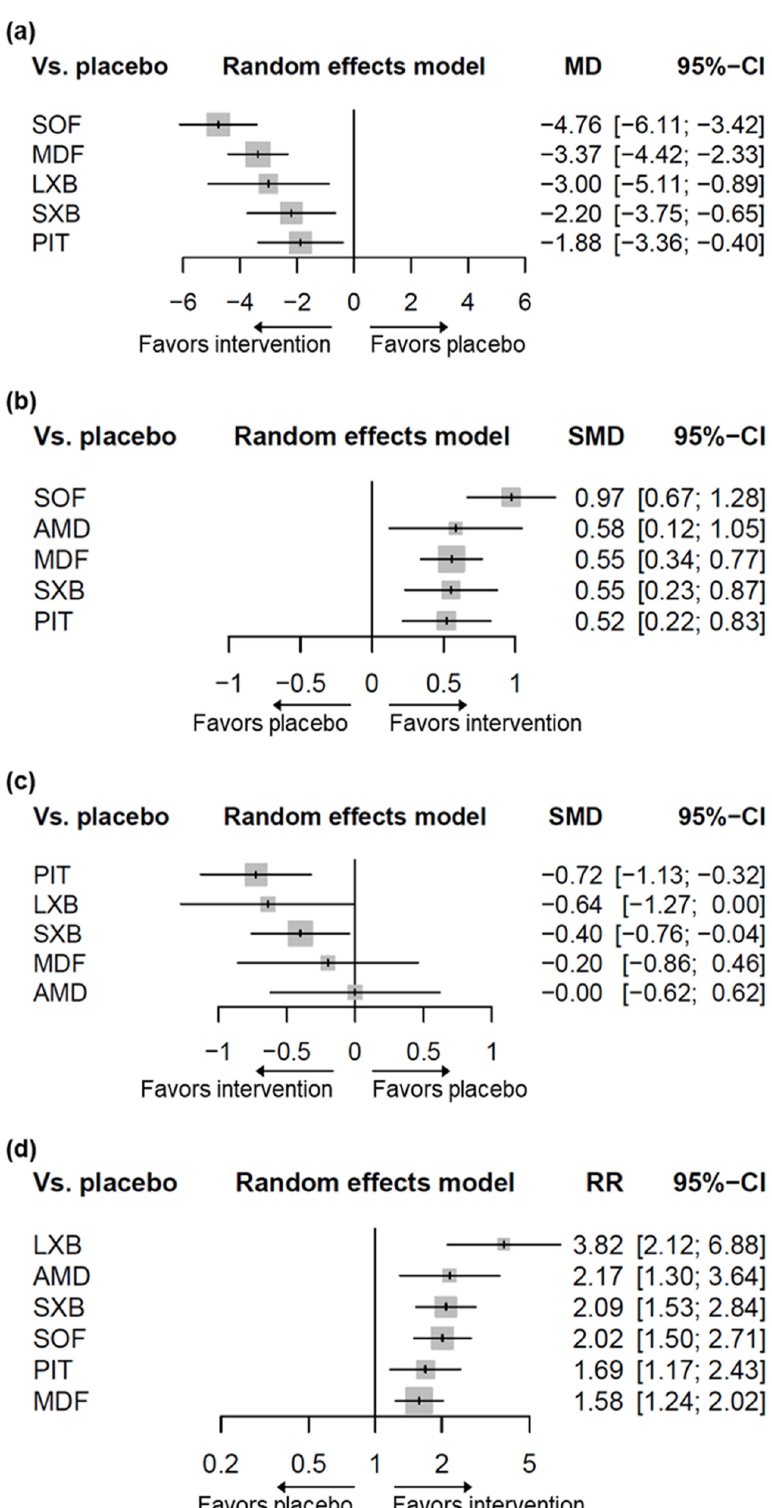
Figure 3. Forest plots for the outcomes of interventions compared to placebo. ( a ) Change in ESS. ( b ) Change in MWT. ( c ) Change in cataplexy rate. ( d ) CGI-C. ESS, Epworth Sleepiness Scale; MWT, Maintenance of Wakefulness Test; CGI-C, Clinical Global Impression of Change; SOF, solriamfetol; LXB, lower-sodium oxybate; MDF, modafinil; SXB, sodium oxybate; PIT, pitolisant; AMD, armodafinil; MD, mean difference; SMD, standardized mean difference; RR, risk ratio; CI, confidence interval.